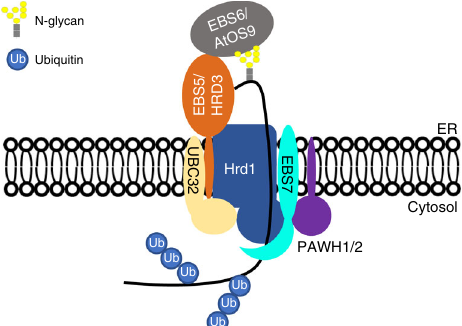
Fig. 7 A model of the Arabidopsis Hrd1 complex. An ERAD-L substrate is recognized and recruited by both EBS6/AtOS9 and EBS5/HRD3 to the ER membrane-anchored Hrd1 that works with the E2 UBC32 to ubiquitinate the ERAD client. EBS7 and PAWH1/2 interact with Hrd1 to regulate the stability and activity of the